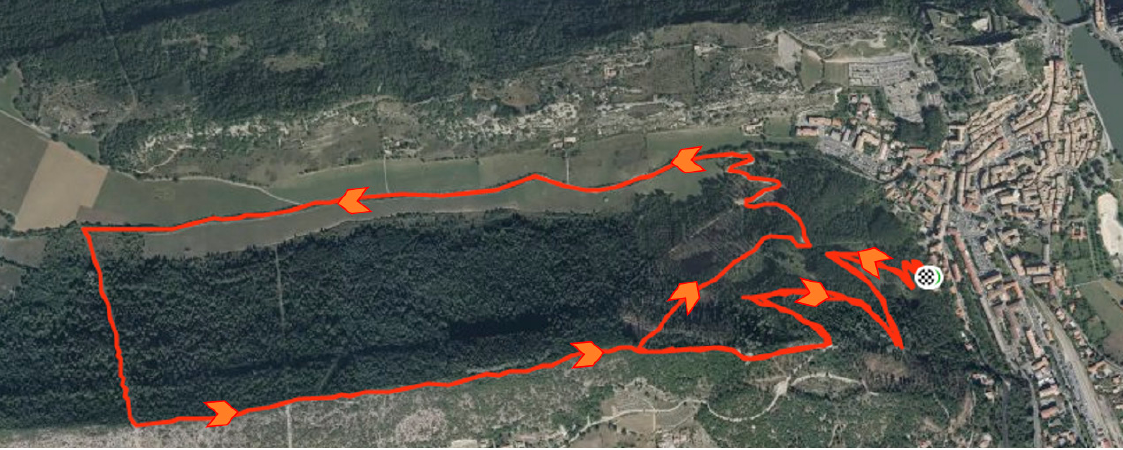
Figure 1. Altimetric profile of the test loop with ascent (UH1), (UH2), descent (DH1), (DH2) and flat (R) sections.